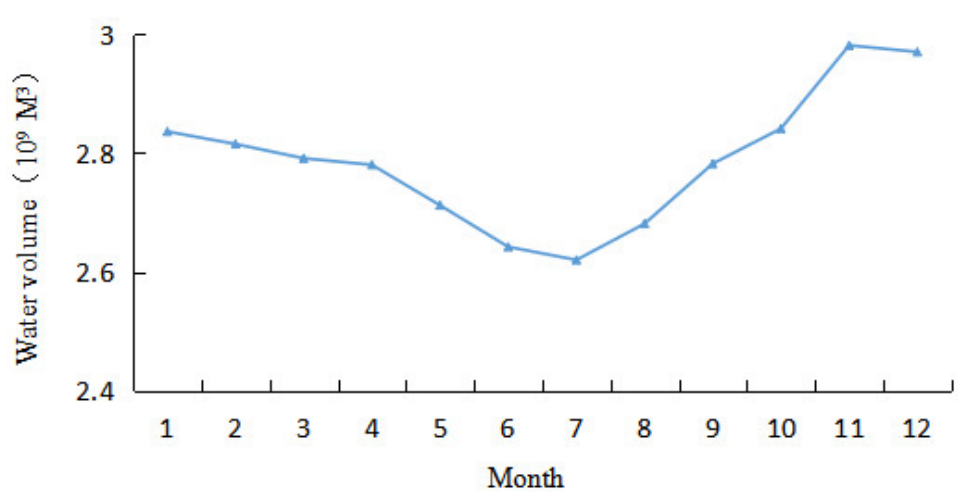
Figure 3. Average monthly water volume change in Erhai Lake from 2000 to 2019.